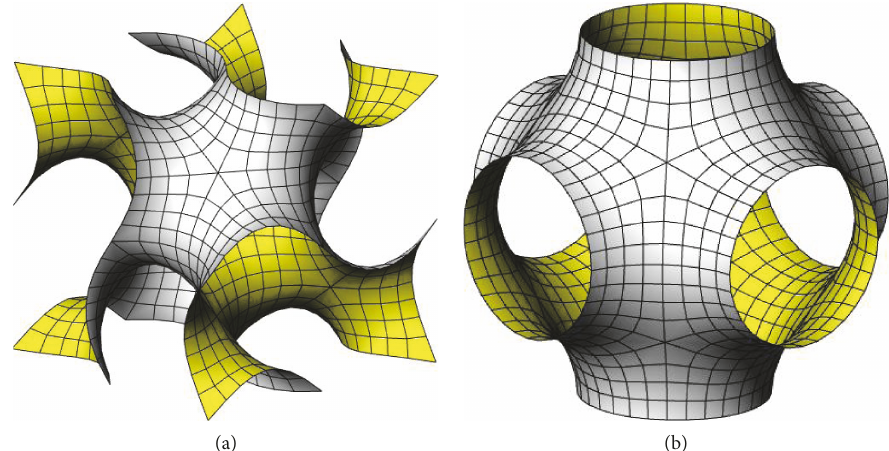
Figure 5: Two types of triply periodic minimal surfaces: (a) Schoen ’ s gyroid and (b) Schwarz ’ s primitive.